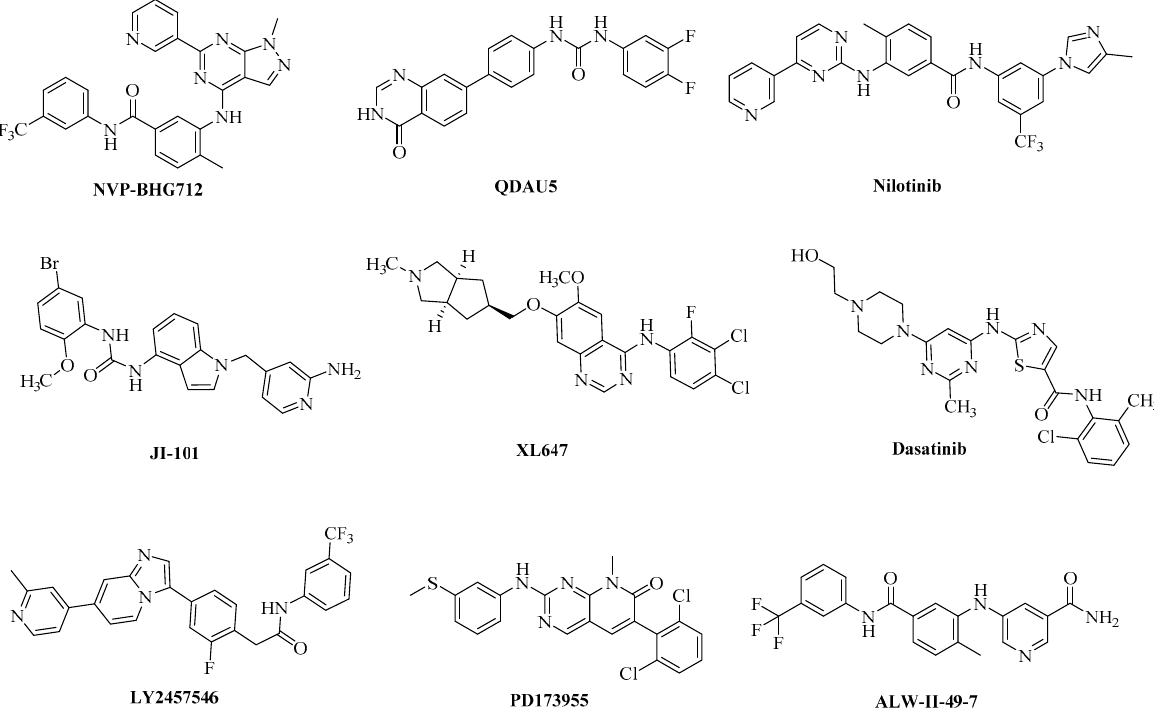
Figure 1. Reported small molecules as Eph inhibitors [18–26].